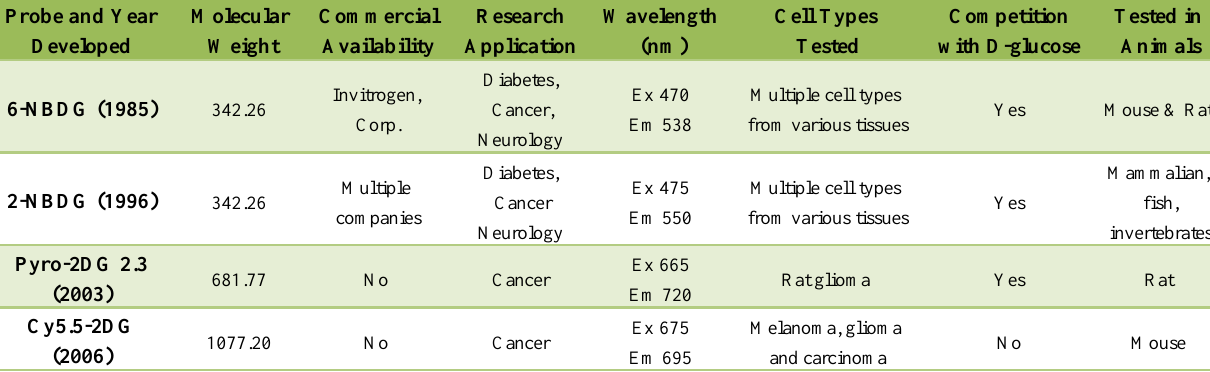
Table 1. A comparison of current fluorescent-tagged glucose